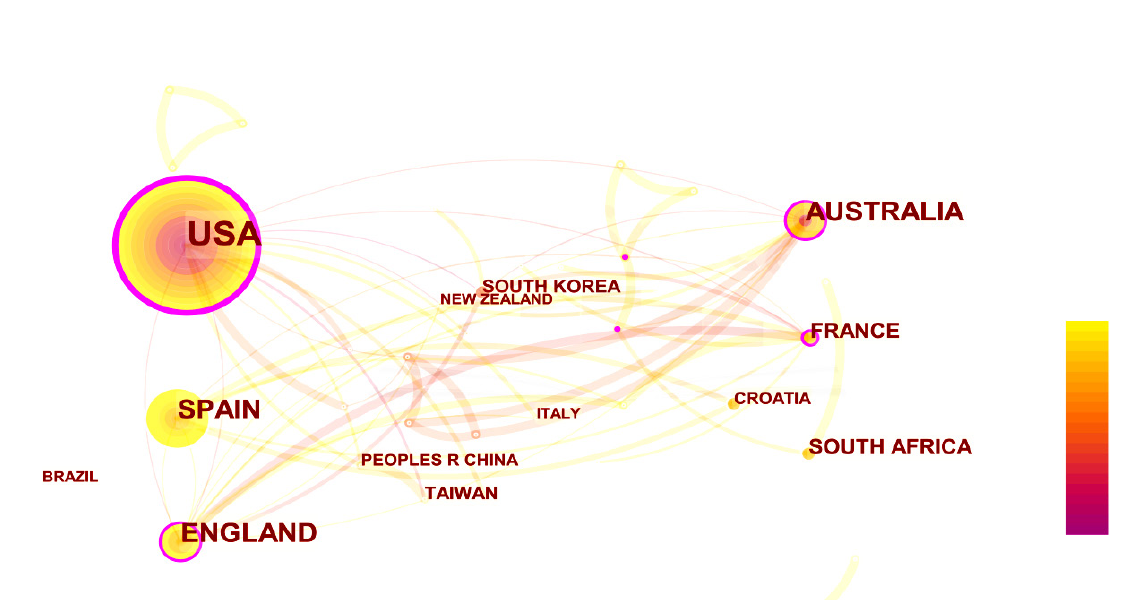
Figure 2. Country co-occurrence map for IMC literature (WoS database)